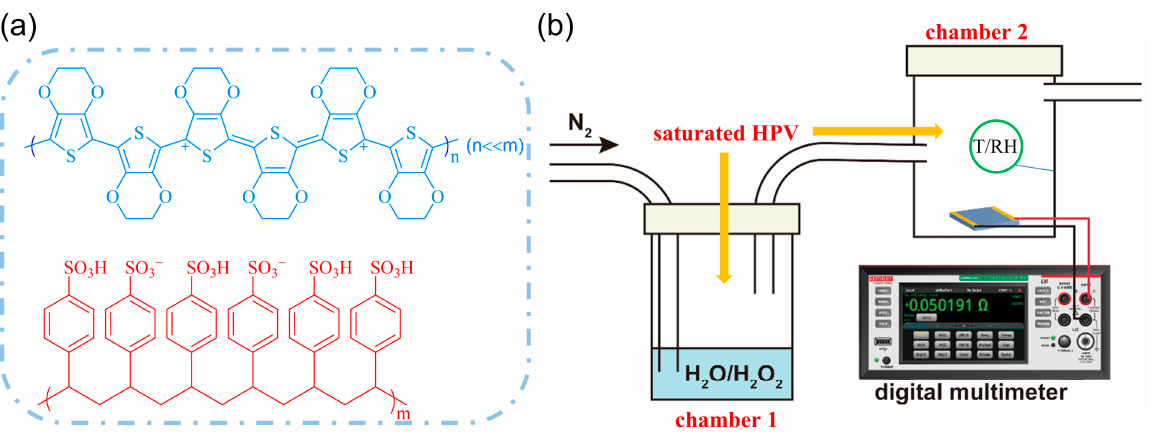
Figure 1. ( a ) Molecular structure of PEDOT:PSS. ( b ) Schematic diagram of HPV-sensing system. Herein, we report a chemiresistive sensor based on PEDOT:PSS/PEDOT film to